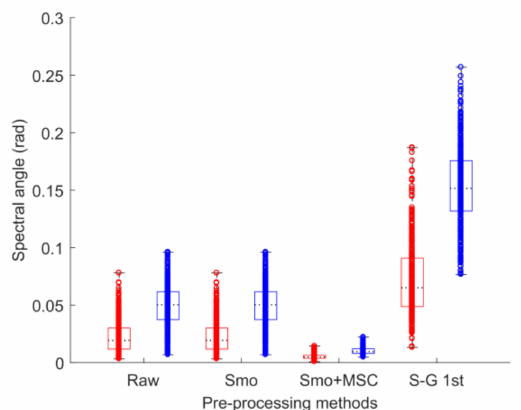
Figure 3. The boxplots of the spectral angle values between all sample spectrums and the reference spectrum with di ff erent pre-processing methods (cultivar H8 in red and H168 in